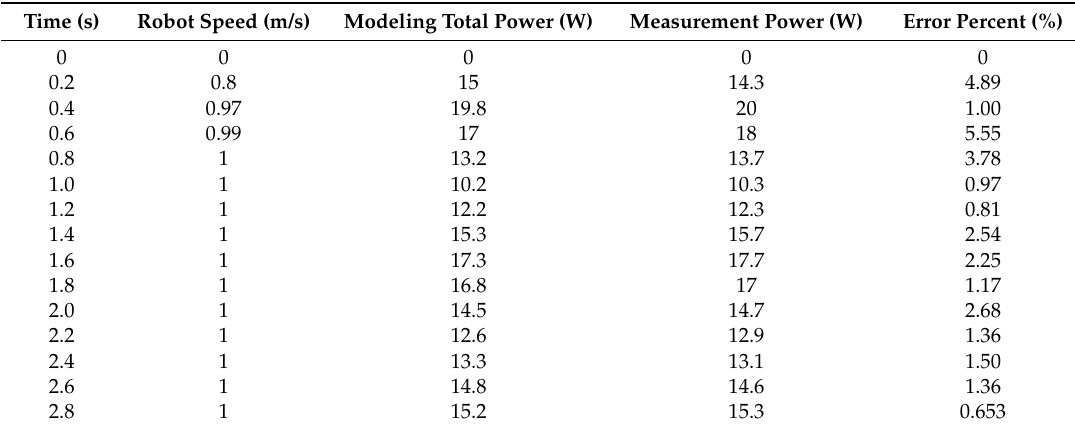
Table 3. Motion power comparison between model and measurement.